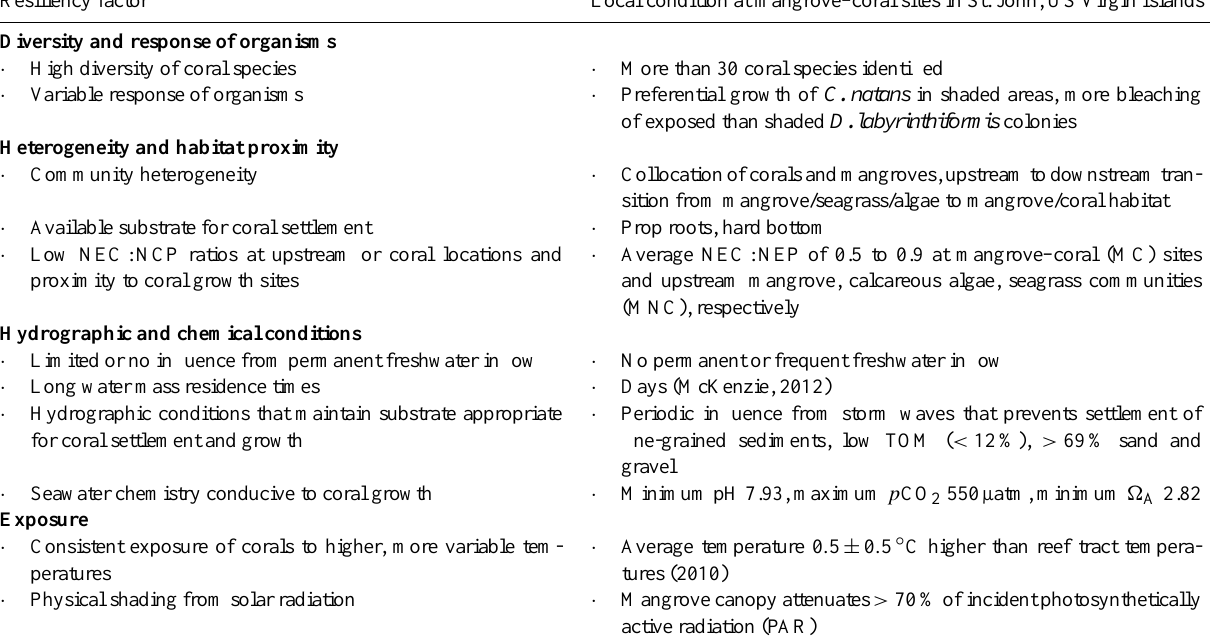
Table 9. Resiliency factors for mangrove–coral refuges. Resiliency factor Local condition at mangrove–coral sites in St. John, US Virgin Islands Diversity and response of organisms · High diversity of coral